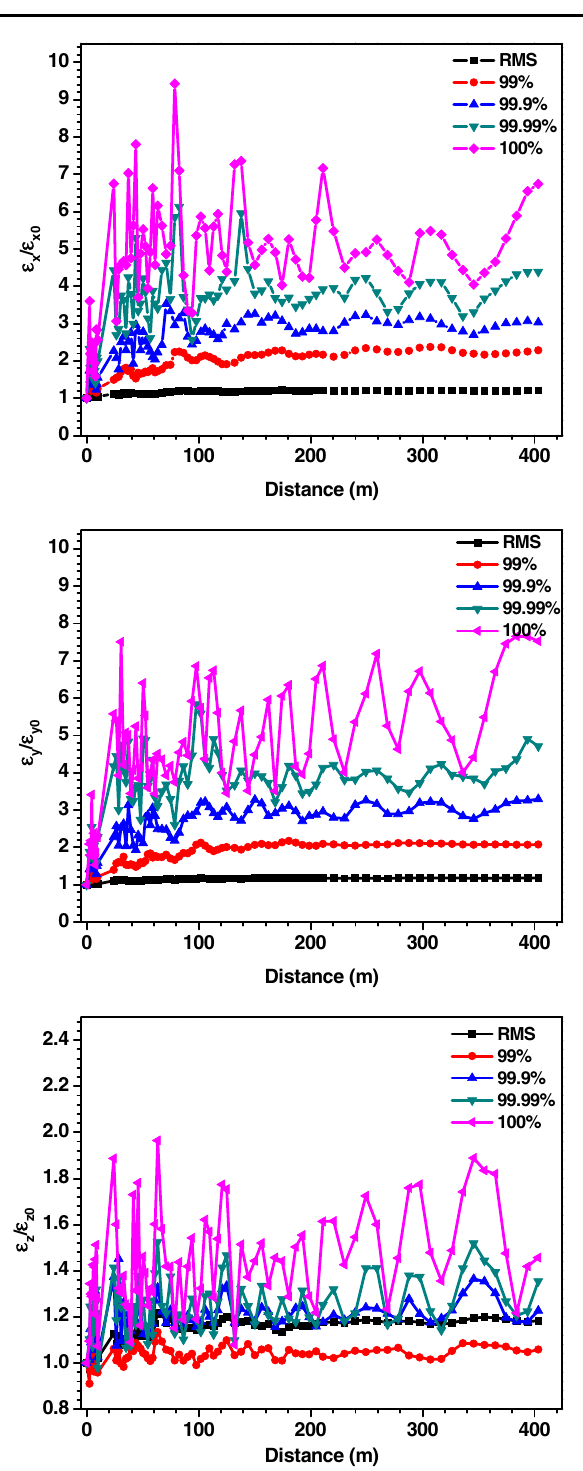
FIG. 28. Halo development along the linac for different beam